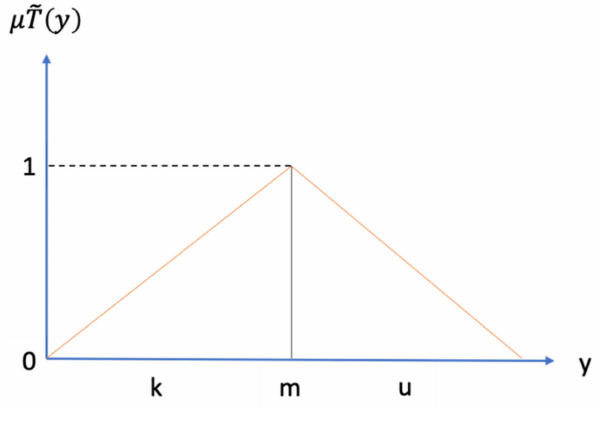
Figure 2. The triangular fuzzy set.